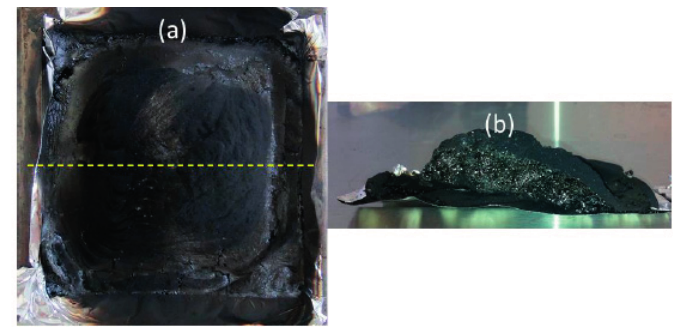
Figure 3. Cone calorimetry residues of PA6/GAS 2.5%/MPP 2.5% viewed from above (yellow line: cross-section) ( a ), and the view of the char cut in the cross-section ( b ).